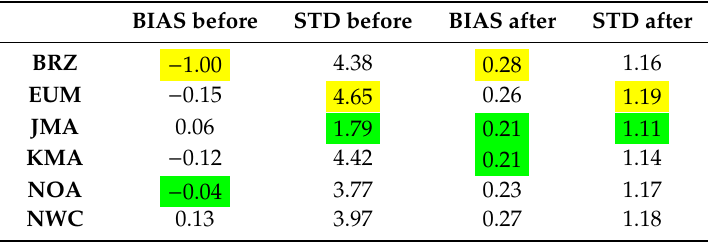
Table 8. Experiment 1: Speed Bias (BIAS) and Speed Standard Deviation (STD) with respect to the NWP analysis winds, before and after the best-fit pressure level correction, for all AMVs for which the best-fit pressure level correction could be applied, with QINF >= 80%. The extremes for each category are highlighted; in yellow, the worst value, and in green, the best value. BIAS before STD before BIAS after STD